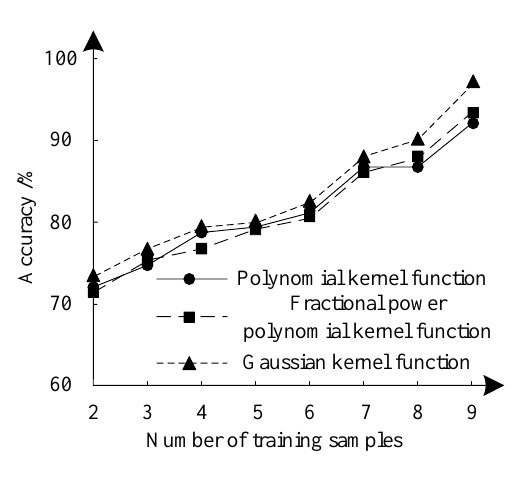
Fig 3. Comparison of average recognition accuracy of different kernel functions